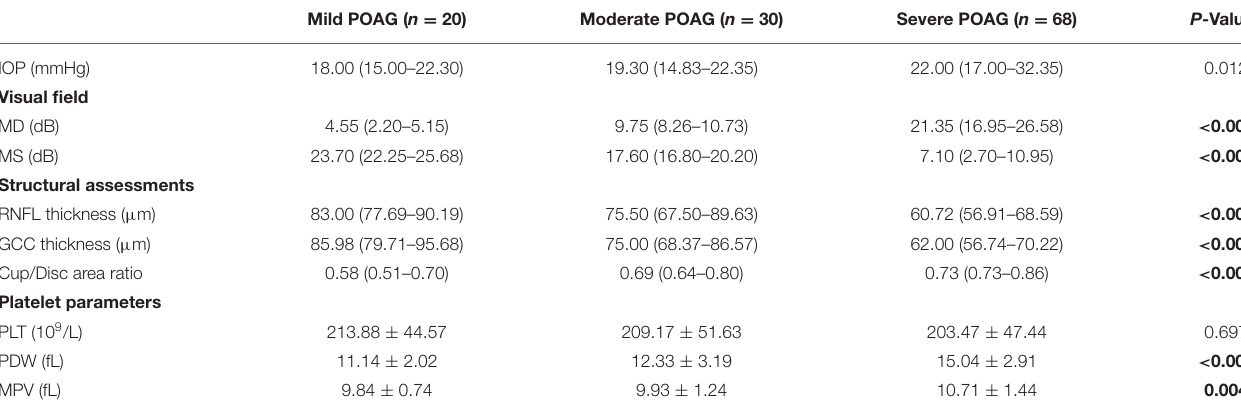
TABLE 2 | Ocular parameters and platelet parameters in patients with POAG, stratified according to severity. Mild POAG ( n = 20) Moderate POAG ( n = 30) Severe POAG ( n = 68) P -Value a